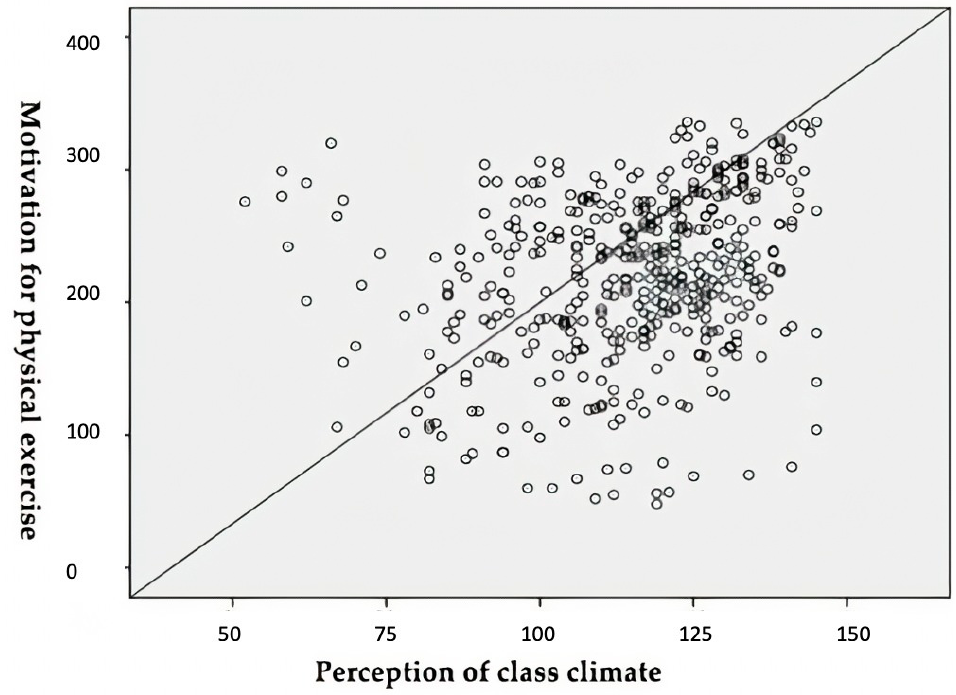
Figure 1. Correlation between AMPEF and